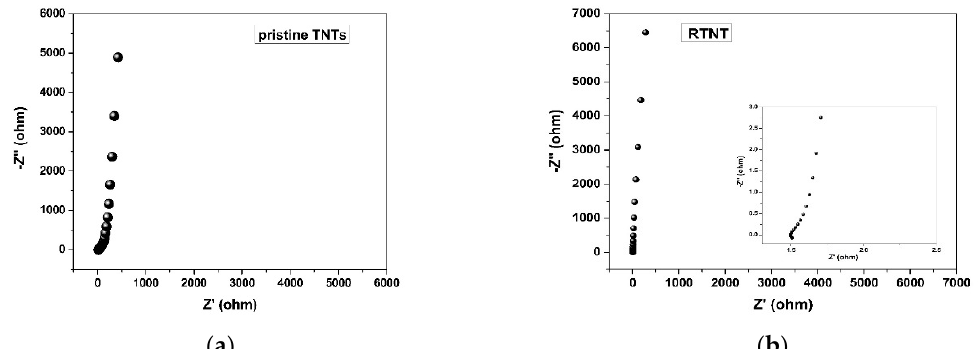
Figure 10. Nyquist plots of ( a ) pristine TNTs and ( b ) R-TNTs with inset showing a magnified high frequency region. Table 3. R s and R ct values for pristine and R-TNTs deduced from Nyquist plots.